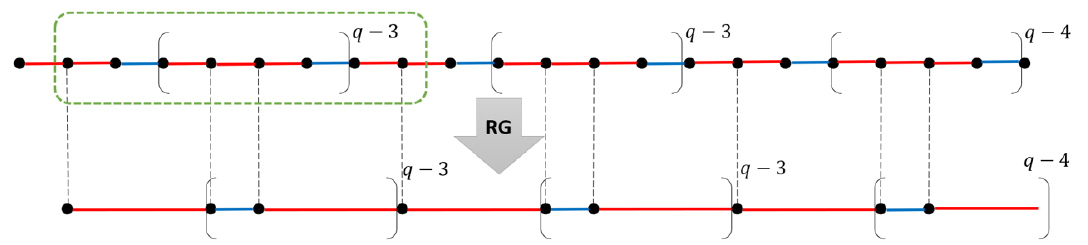
Figure 7: Top line: Typical asymptotic sequence arising from the { 6, q } inflation rule (35). Strong bonds J are depicted in blue, weak bonds J in red. The gray brackets b a imply the repetition of the letter sequence enclosed by them in analogy to usual exponentiation, i.e. ( abb ) 2 ≡ abbabb . A decimation procedure associated to the RG step (36) is performed, whereby some repeated sub-structures like the one inside the green box can be renormalized as a whole to a new sequence. Bottom line: Resulting sequence after one RG step which is different from the original